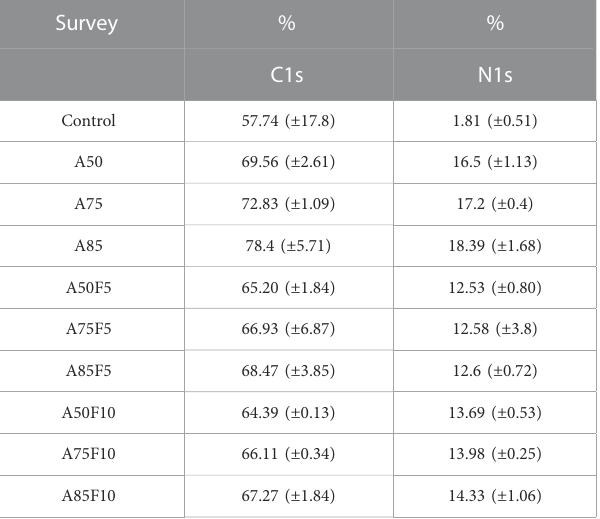
TABLE 2 Elemental composition results by